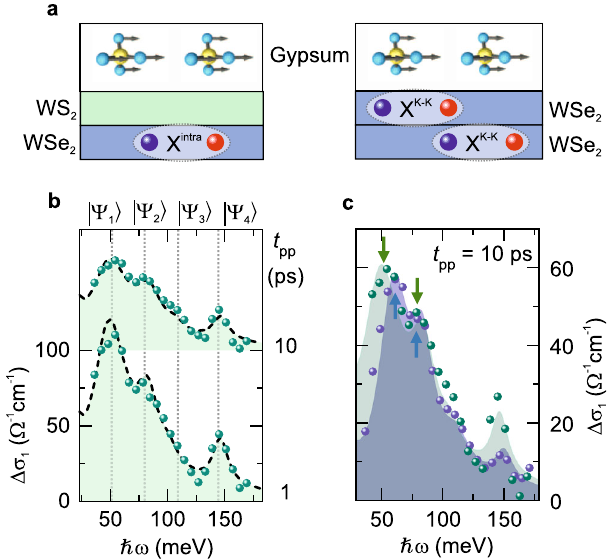
Fig. 4 MIR response of the WSe 2 /WS 2 /gypsum heterostructure and comparison to the WSe 2 BL/gypsum heterostructure. a Schematic of the spatial distribution of the excitons in the WSe 2 /WS 2 /gypsum (left) and the WSe 2 BL/gypsum (right) heterostructure. The relative distance of intralayer excitons (X intra in the WSe 2 /WS 2 heterostructure and X K (cid:1) K in the WSe 2 BL) to the vibrational modes in gypsum yields different coupling strength. b Pump-induced change of the real part of the optical conductivity Δ σ t 1 for different pp for a WSe 2 /WS 2 /gypsum heterostructure ( Green spheres: experimental data. Black dashed line: theoretical simulation. Gray dotted lines indicate the spectral positions of Ψ n between Δ σ 1 of the WSe 2 /WS 2 /gypsum (green) and the WSe 2 BL/gypsum (blue) heterostructure at t pp = 10 ps. Spheres: experimental data. Shaded areas: theoretical simulation. Green and blue arrows indicate the positions (cid:3) (cid:3) (cid:4) (cid:4) (cid:3) (cid:3) of Ψ and Ψ 1 2